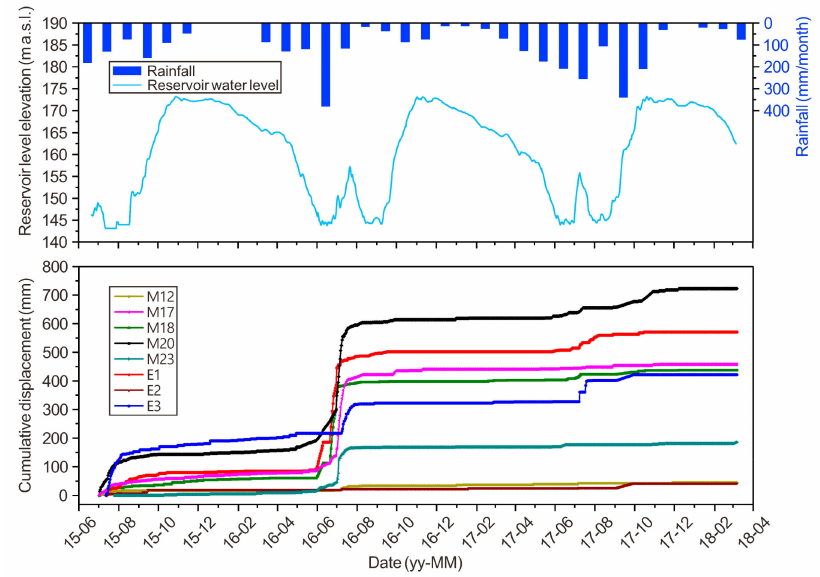
Figure 12. Displacement–time curves obtained from different instruments.